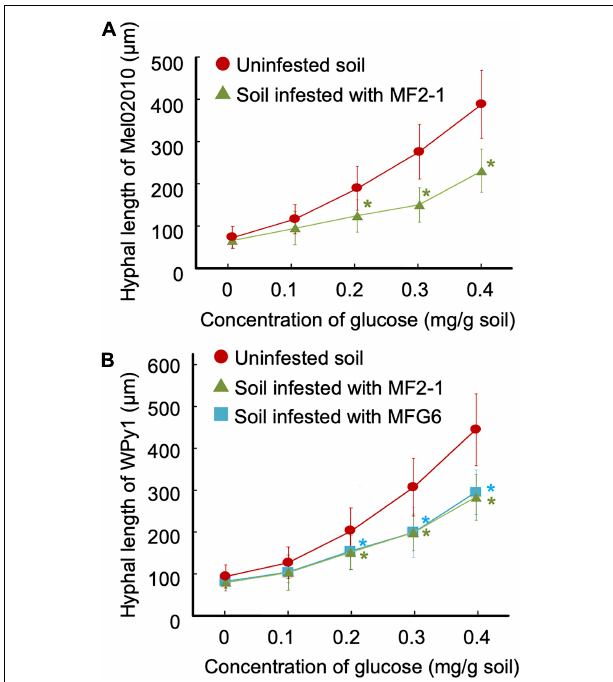
FIGURE 8 | Carbon source competition between pathogenic and nonpathogenic strains in soil. Cellulose membrane filters with conidia of strain Mel02010 of Fusarium oxysporum f. sp. melonis (A) and oospores of strain WPy1 of Pythium aphanidermatum (B) were set in soil mixed with glucose solution (0–0.4 mg/g soil) and a conidial suspension (1 × 10 5 conidia/g soil) of nonpathogenic strains. After 3 days, the filters were removed from the soil, and the length of hyphae of Mel02010 and WPy1 was measured. Data represent means and standard errors of three replicates. Asterisks indicate a significant difference in hyphal length from that in uninfested soil at each glucose concentration ( P < 0.001; Student’s t -test). MF2-1, FOW2 mutant of Mel02010; MFG6, nonpathogenic F. oxysporum .